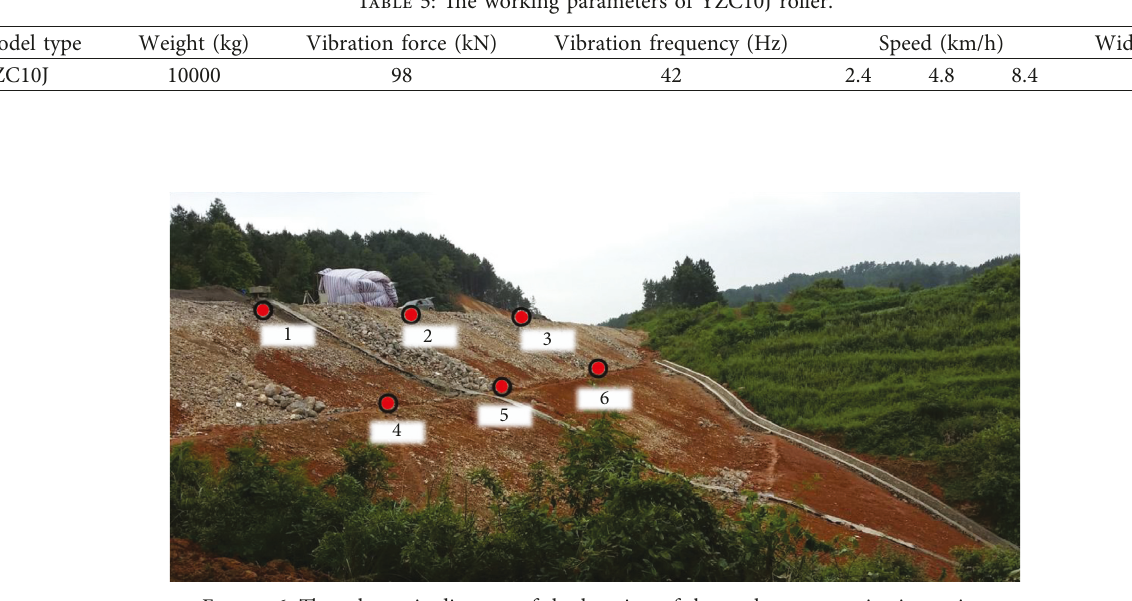
Figure 6: The schematic diagram of the location of the settlement monitoring point.